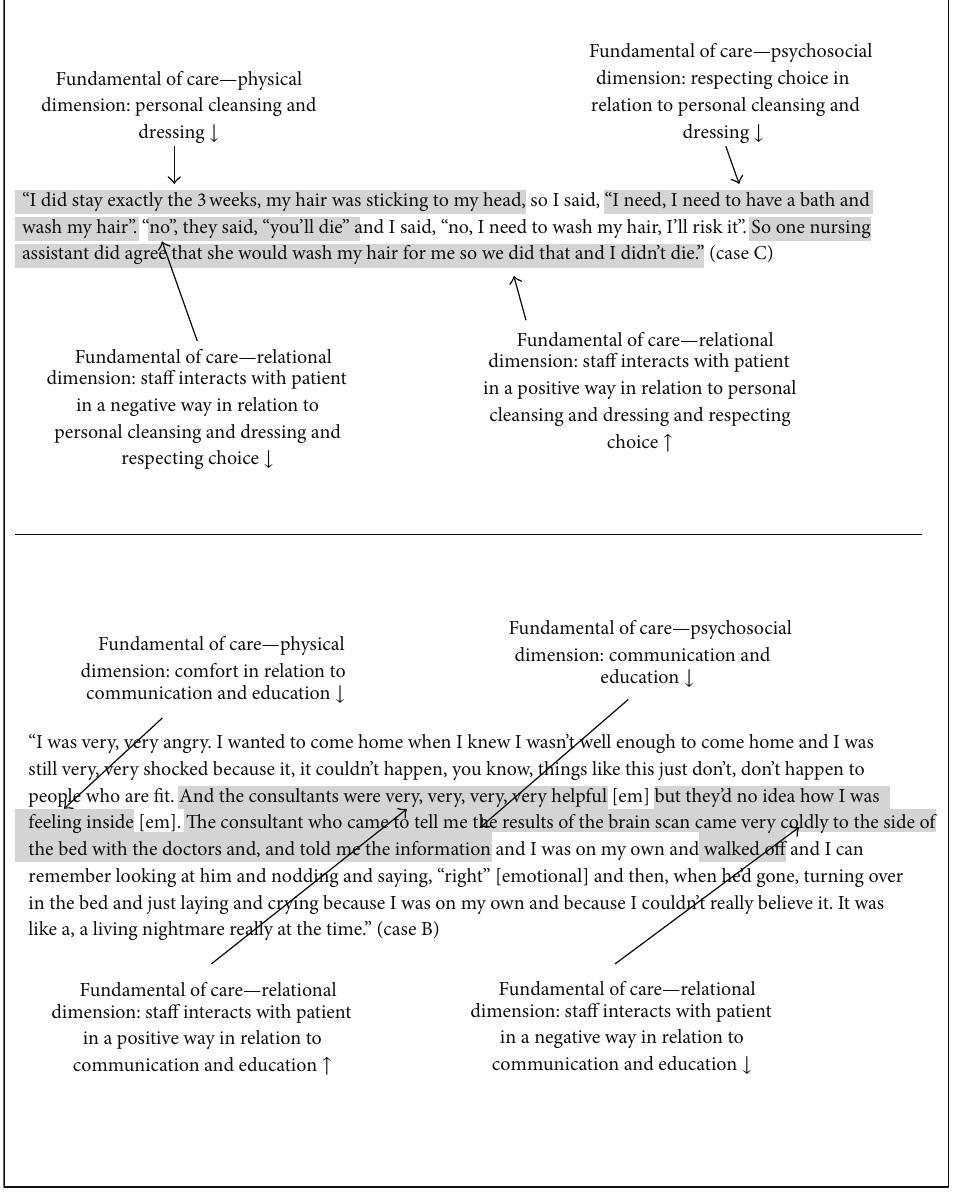
Figure 2: Data analysis process: examples of the text indicating the interpretation of the physical, the psychosocial and the relational